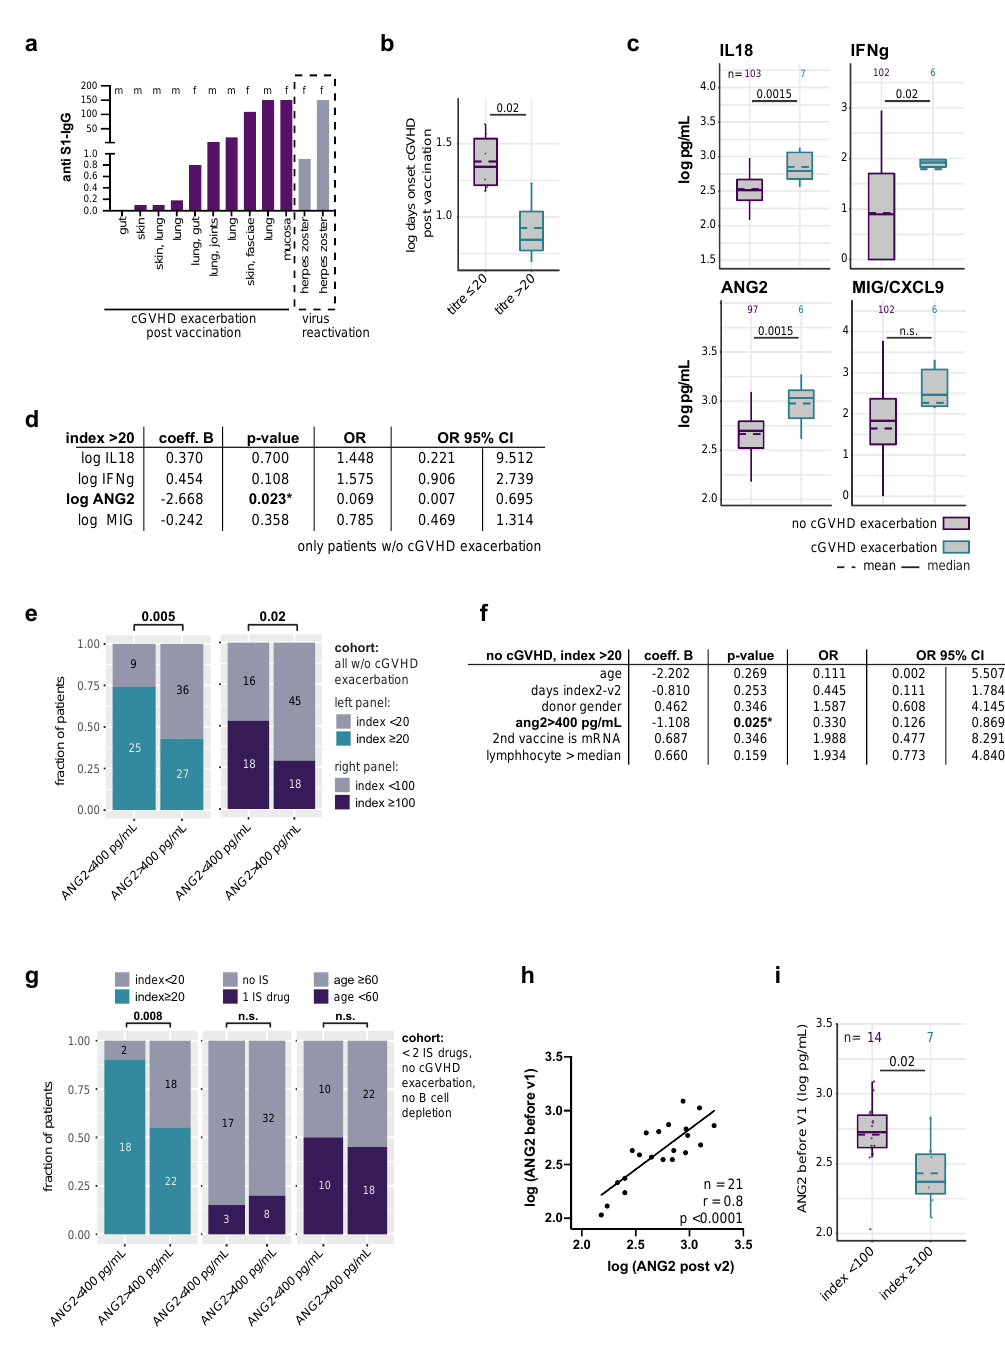
Figure 2. Adverse events and biomarkers in alloSCT patients undergoing COVID-19 vaccination. (a) Bar graph indicating the anti-S1 IgG level of 10 patients suffering exacerbation of cGVHD post vaccination and 2 patients with herpes zoster post vaccination. Exacerbation of cGVHD was defined as the need for IS treatment escalation or re-start of IS treatment in patients off IS at the time of the first vaccination. Letters on top indicate patients’ gender showing no enrichment of either gender ; 173 organs below bars indicate the organs affected by cGVHD; (b) Boxplot indicating the mean (dashed 174 line) and median (horizontal line) log days between vaccination and onset of symptoms in patients 175 with index > 20. Unpaired t-test, p = 0.02; (c) Log-transformed cytokine levels (pg/mL) of four 176